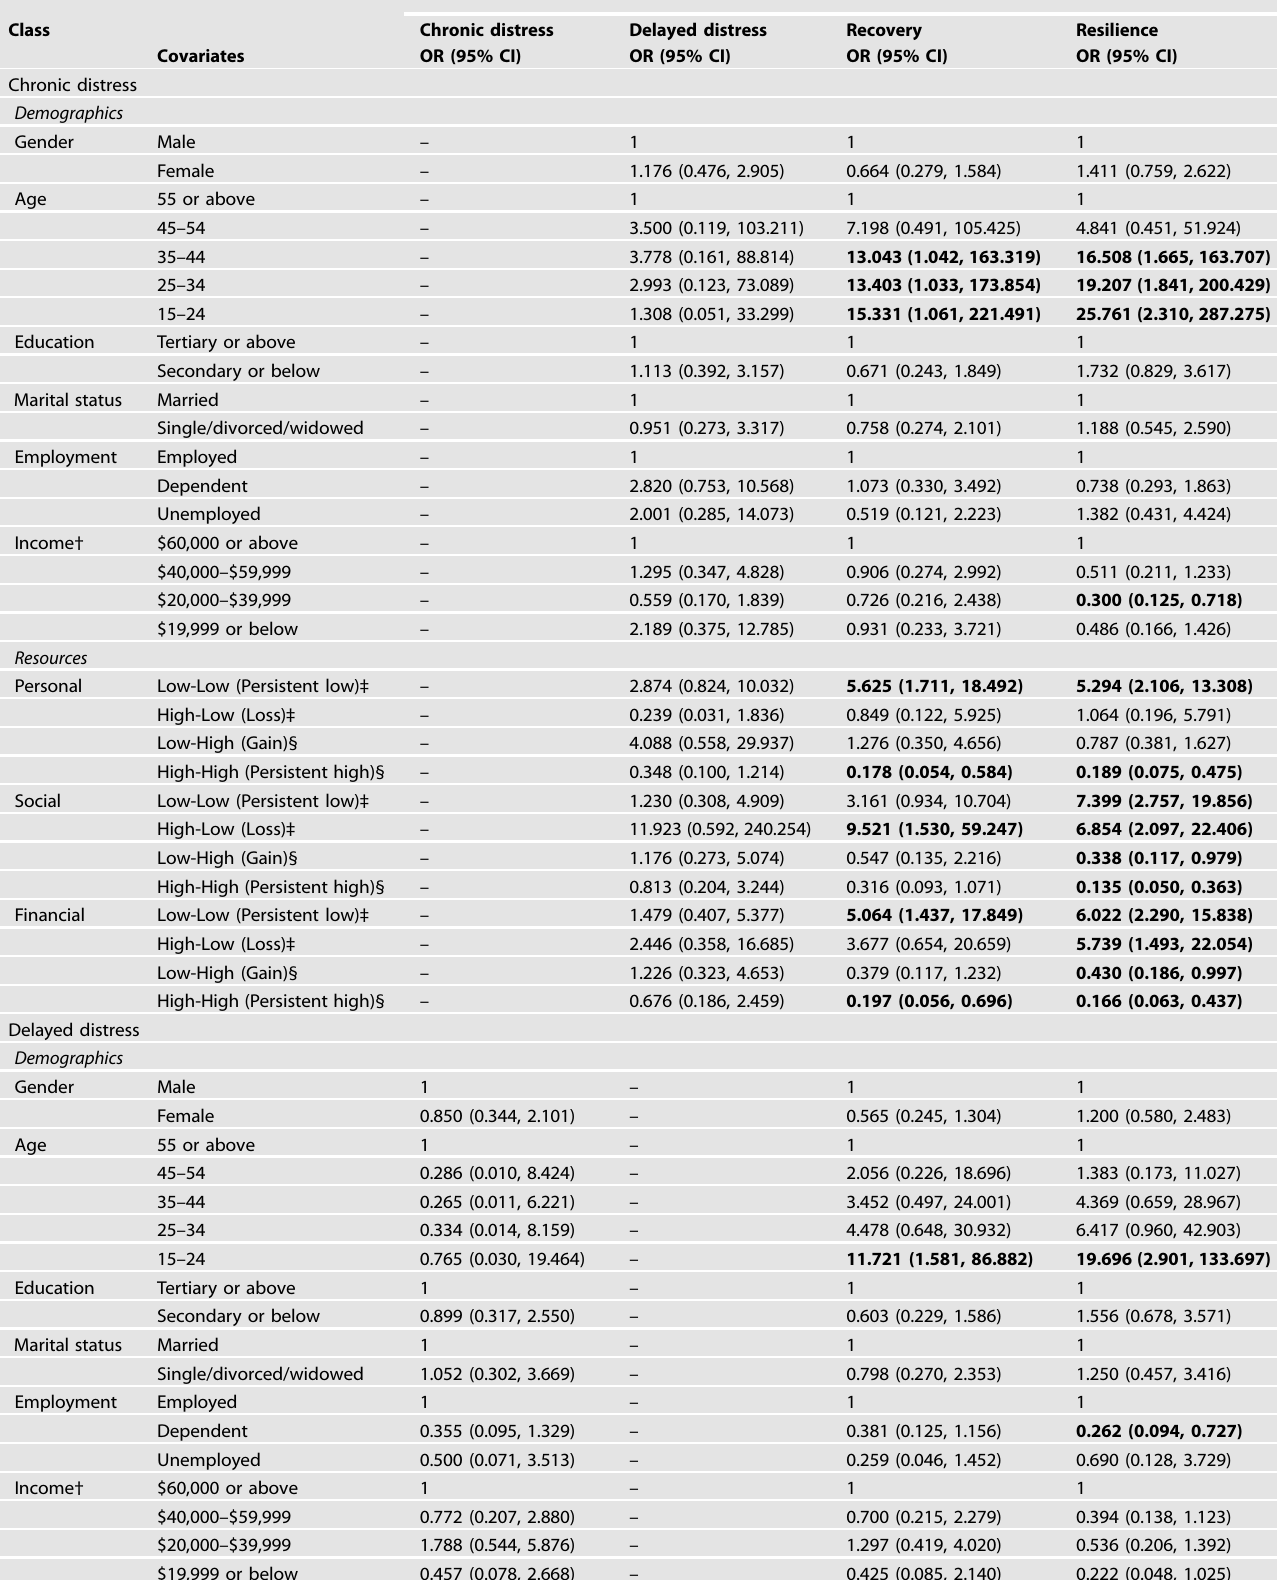
Table 3. Conditional growth mixture modeling (GMM) results of depressive symptom